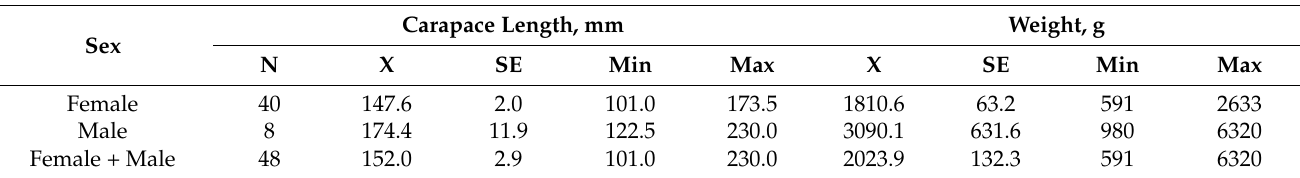
Table 1. Size and weight parameters of red king crabs from Dalnezelenetskaya Bay used in fatty acid